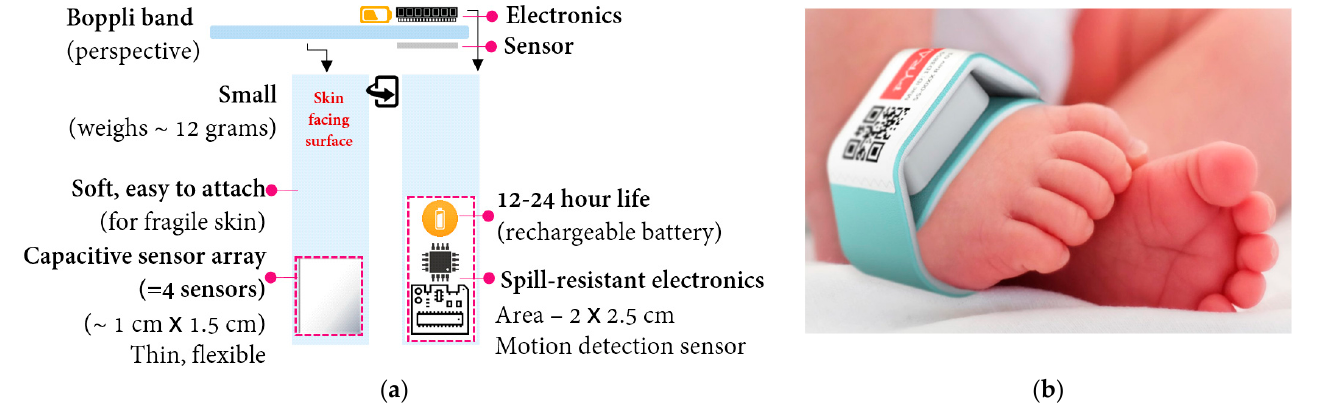
Figure 1. ( a ) Boppli sensor schematic: illustration of the sensor and wearable, continuous, non-invasive BP device for neonates (cross-sectional at the top; aerial view at the bottom); ( b ) Boppli sensor placement around the foot of an infant.